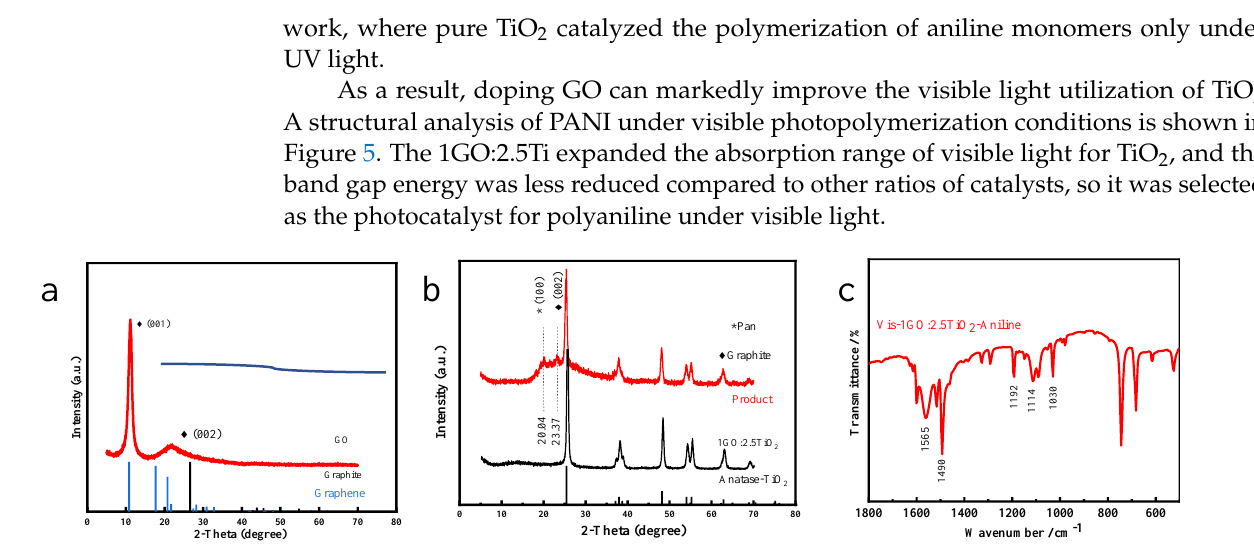
Figure 5. Structural analysis of PANI under visible photopolymerization conditions: ( a , b ) XRD patterns and ( c ) FT-IR spectrum.